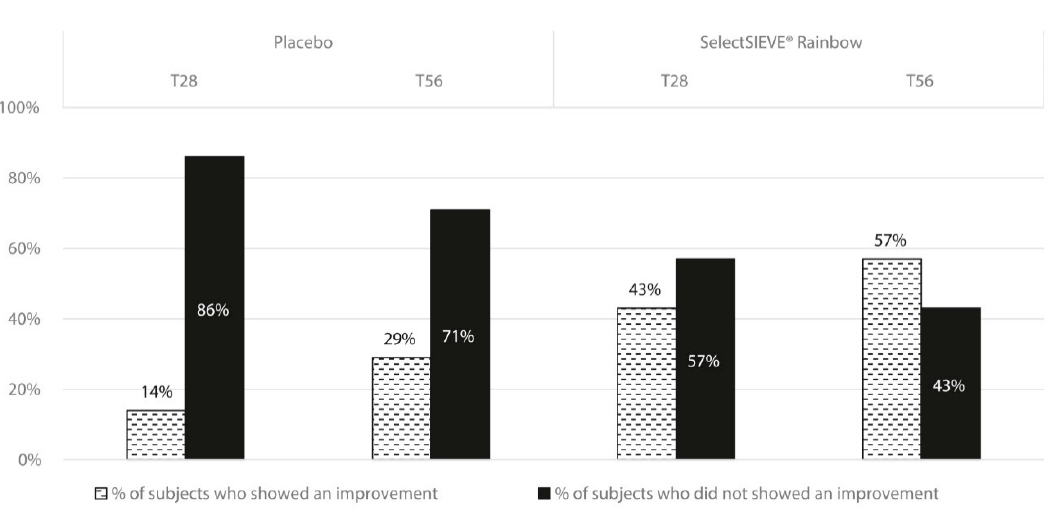
Figure 6. Clinical evaluation of the cellulite skin-derived imperfections (“orange peel”). The graph shows the percentage of subjects, belonging to the placebo and the SelectSIEVE ® Rainbow group, who showed or did not show an improvement based on the clinical evaluation.